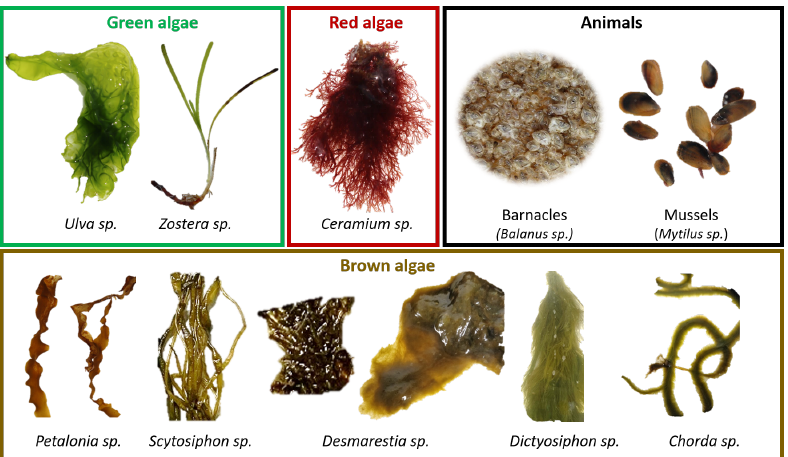
Figure 1. Biofouling species collected in Hundested and used to construct a spectral